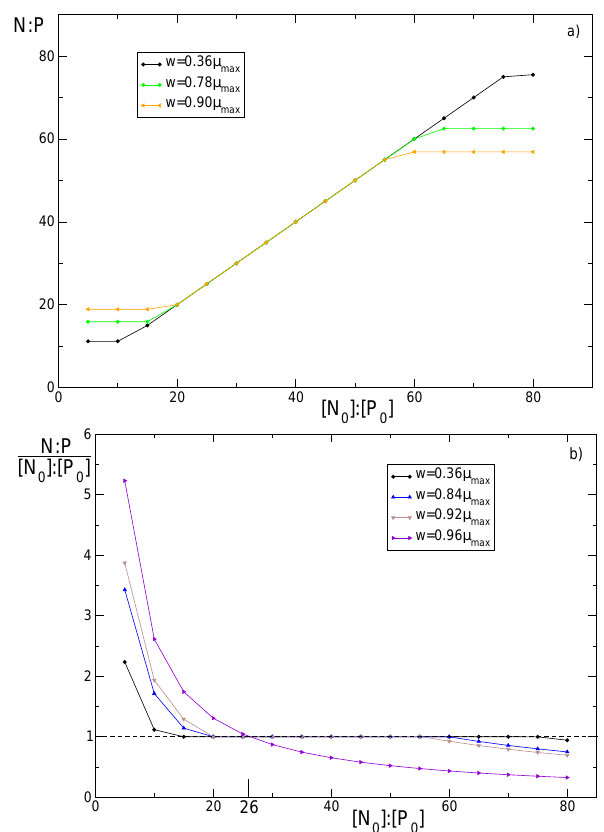
Fig. 6. (a) N : P ratio for the cell as a function of the nutrient supply ratio for different chemostat dilution rates. (b) The optimal ratio is defined as the input ratio for which the internal ratio of the nutrients match the input ratio regardless of the dilution rate; for the generic Synechococcus parametrization used here, [ N 0 ] : [ P 0 ] opt ∼ 26 .